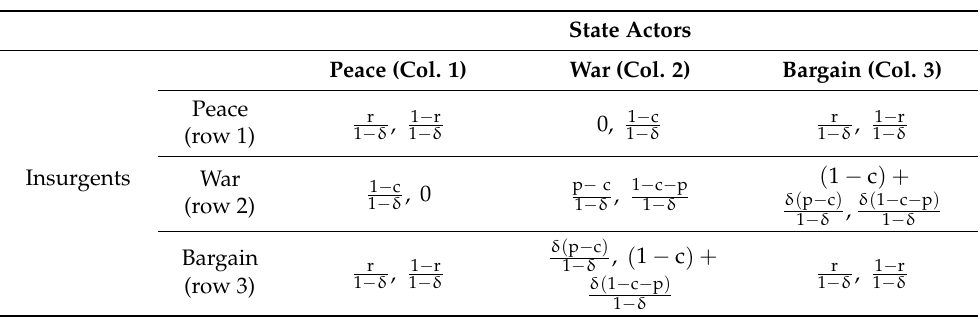
Table 1. Fitness Matrix.